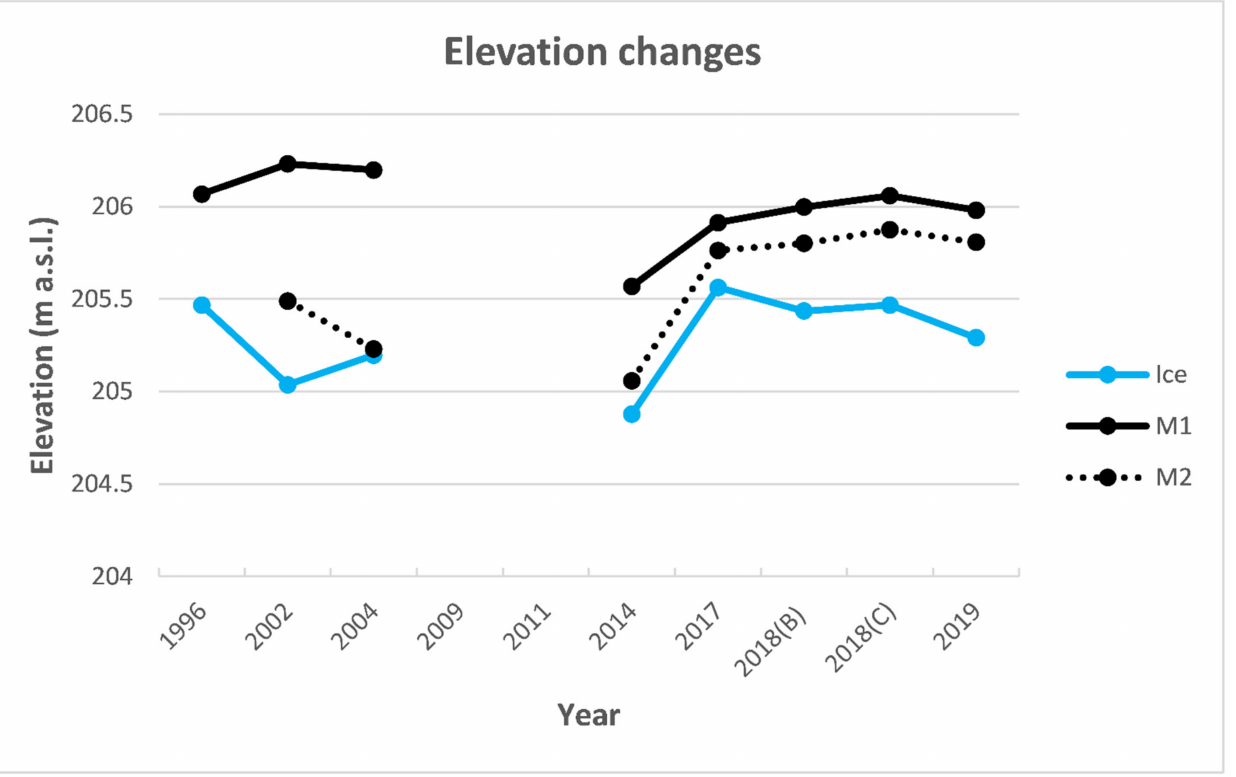
Figure 4. Elevation changes (m a.s.l.) between 1996 and 2019 (see also Table 2). From 1996 to 2014 the pattern relied on pixel analysis, while from 2017 to 2019 on DEM differencing. This could explain the large increase between 2014 and